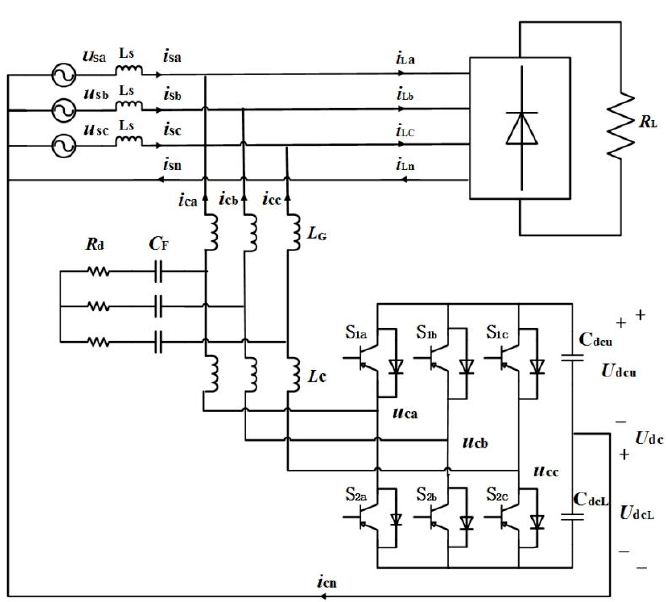
Figure 1. Topology of three-phase four-wire center-split shunt APF.